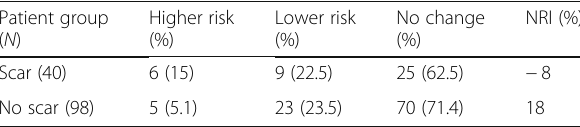
Table 6 Patient reclassification when applying entropy Patient group ( N